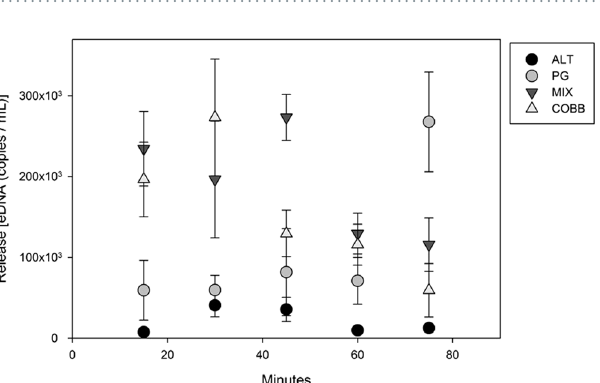
Table 1. Parameter estimates for eDNA movement in LEEF streams using equations noted in methods.